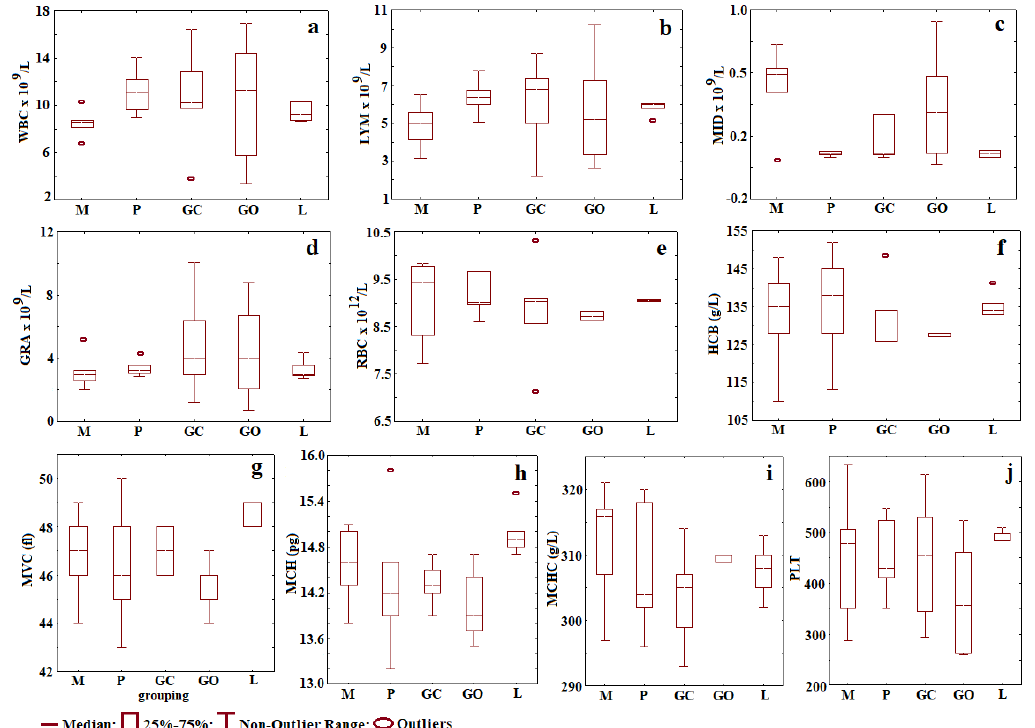
Figure 9. Means and standard deviations for all groups and variables without outliers: ( a ) WBC; ( b ) LYM; ( c ) MID; ( d ) GRA; ( e ) RBC; ( f ) HGB; ( g ) MVC; ( h ) MCH; ( i ) MCHC; ( j ) PLT. (Physiological values: WBC: 4 – 12 × 10 9 /L, LYM: 2 – 14.1 × 10 9 /L, MID: 0 – 0.98 × 10 9 /L, GRA: 0.1 – 5.4 × 10 9 /L, RBC: 9 – 15 × 10 12 /L, HGB 90 – 150 mg/dL, HCT: 24 – 45%, PLT: 250 – 750 × 10 9 /L; * p < 0.05; ** p < 0.01; *** p < 0.001.)